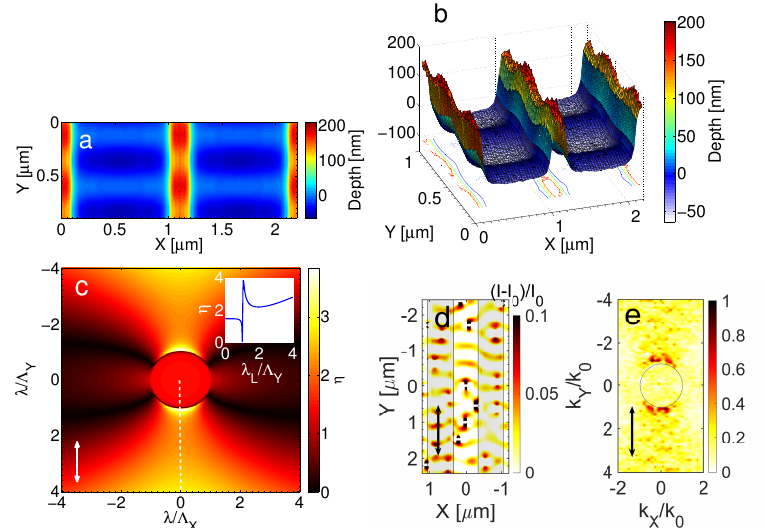
Figure 5. Topography following irradiation of Nickel with fifteen laser pulses: ( a ) upper view (at 1026 nm) and ( b ) side view (at 1026 nm). Polarisation is along the Y -axis. ( c ) Efficacy Factor map for LIPSS formation (at 513 nm); the inset shows η along the white dashed line ( white double headed arrow indicates the laser polarisation direction). ( d ) Electromagnetic simulations that shows surface wave propagation direction and periodicity (at λ = 513 nm) on a XY -plane and the corresponding FFT ( e ); vertical shaded regions indicate the position of the prepatterned ridges. The periodicity of the scattered waves (far fields) is equal to Λ Y (=2 π / k Y ) and they are captured in the FFT fig- ure where k 0 = 2 π / λ is the free-space wavevector ( black double headed arrow indicates the laser polarisation